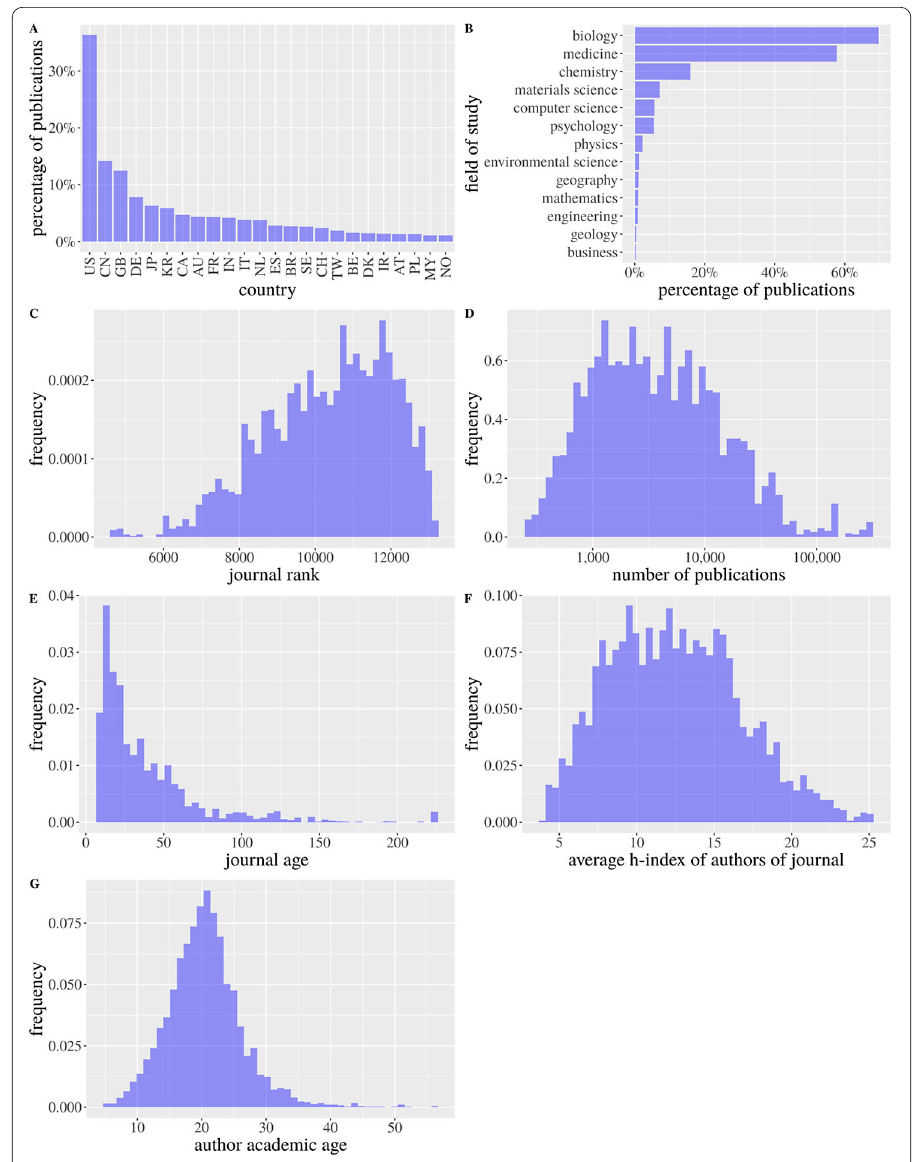
Figure 3 Distribution of journals’ affiliation country, the field of study, rank, number of publications, age, average author h-index, and author academic